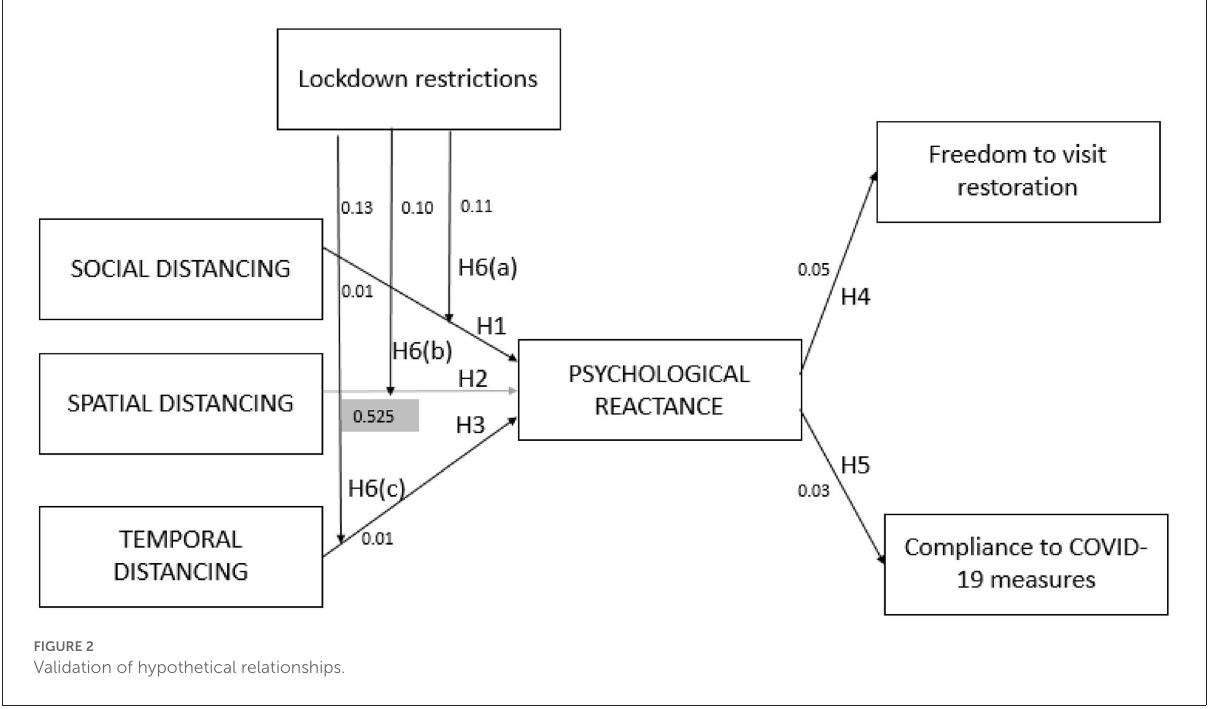
FIGURE2 Validation of hypothetical relationships.